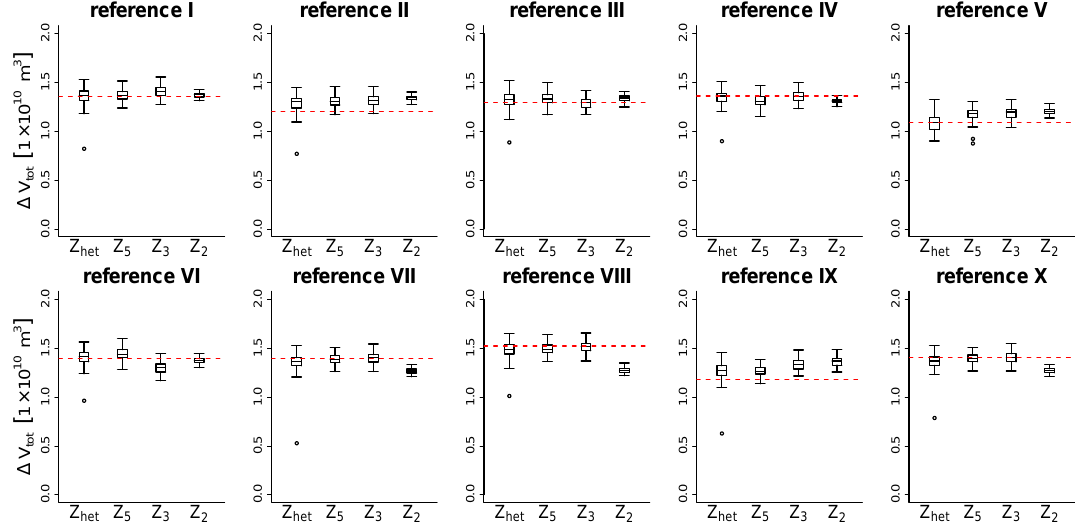
Fig. 12. Total amount of water exchanged between river and aquifer over the whole simulation period (609 days) for conditional simulations with EnKF (scenario B). Red lines mark the water exchange for the different reference